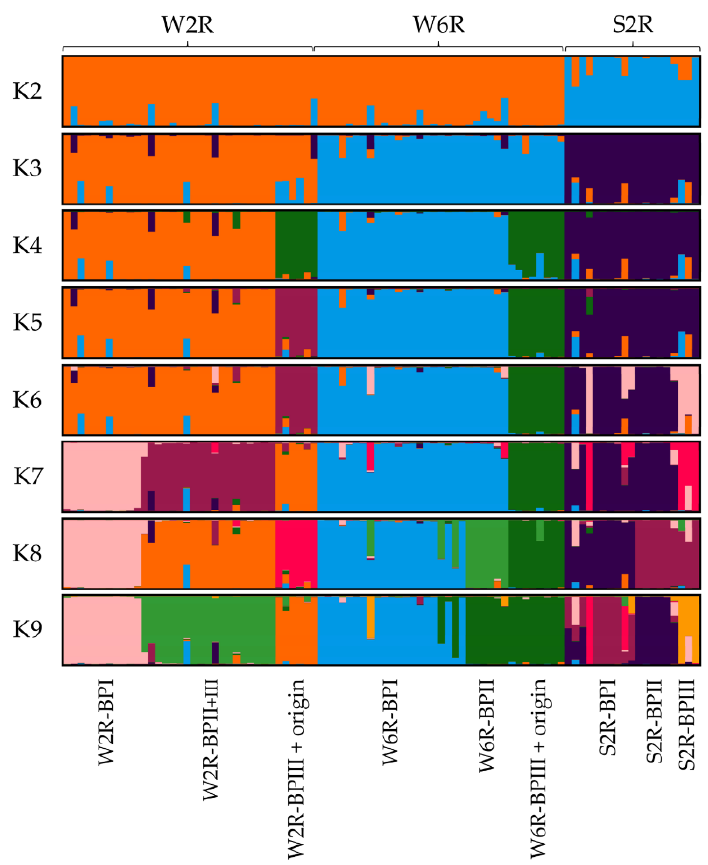
Figure 1. Inferred structure of 90 barley genotypes estimated with Clumpak distruct analysis. Each variety is represented by a vertical line which is divided into K colored segments proportional to the likelihood of its membership to the assigned cluster from K = 2 to K = 9. W2R—two-rowed winter genotypes, W6R—six-rowed winter genotypes, S2R—two-rowed spring genotypes, BPI—the first breeding period, BPII—the second breeding period, BPIII—the third breeding